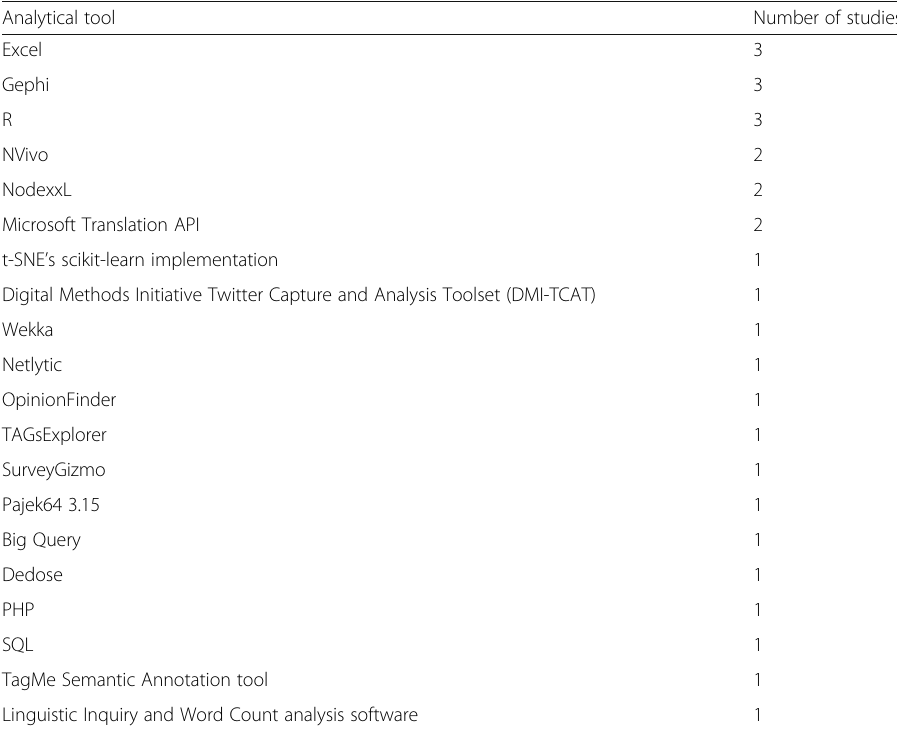
Table 3 Software Tools Used to Analyse Tweets Analytical tool Number of studies